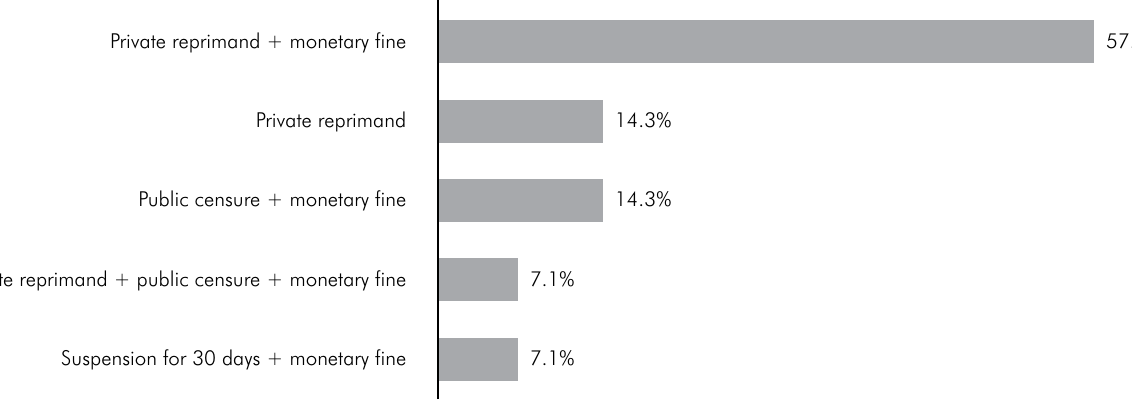
Figure 2. Percent distribution of lawsuits analyzed at the CRO/ES between 2000 and 2010, according to the penalties applied to dentists. Source: CRO/ES, Vitória,